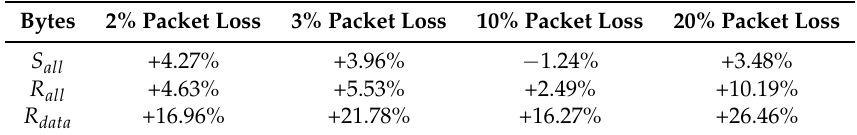
Table 11. Comparison of the two simulation modes for a more realistic scenario with various amount of congestion.